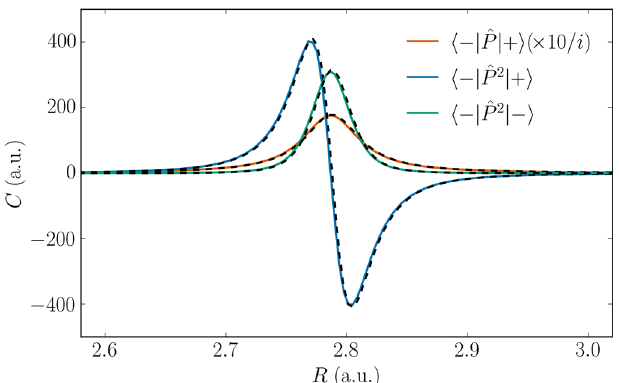
FIG. 8. Non-Born-Oppenheimer correction terms coupling the “ lower polariton ” and “ upper polariton ” PES for a single anthracenelike model molecule for a coupling strength of g ¼ 0 . 002 a : u : . Solid colored lines: results from a full numerical calculation. Dashed black lines: results from the model Eq. (A4). Note that while all results are given in atomic units, ˆ P ˆ P 2 the units of the and terms are not identical, and thus not directly